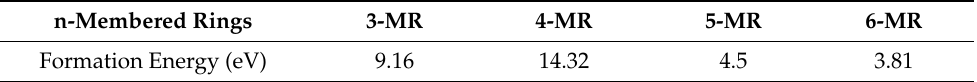
Table 1. Distribution table of formation energy of bismuth atom gap